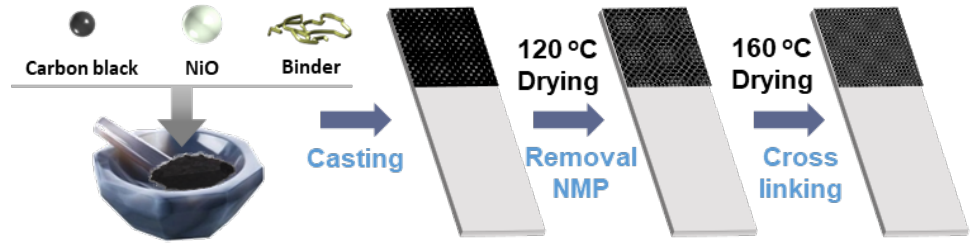
Figure 7. Schematic illustration of working electrode.